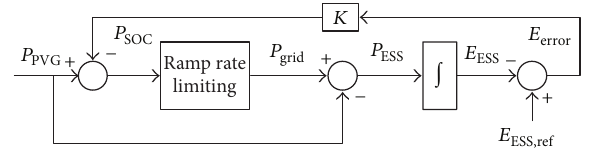
Figure 3: Block diagram of the used PV power ramp rate limiting procedure using an energy storage system equipped with state of charge control